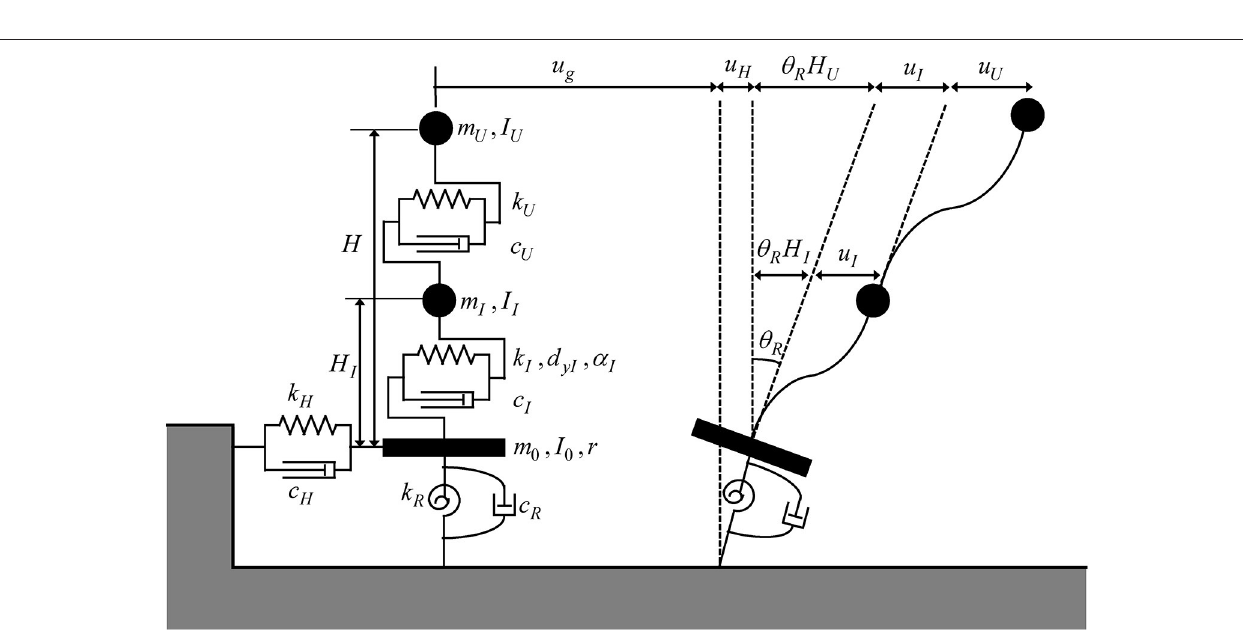
FIGURE 8 | Relation of deformation